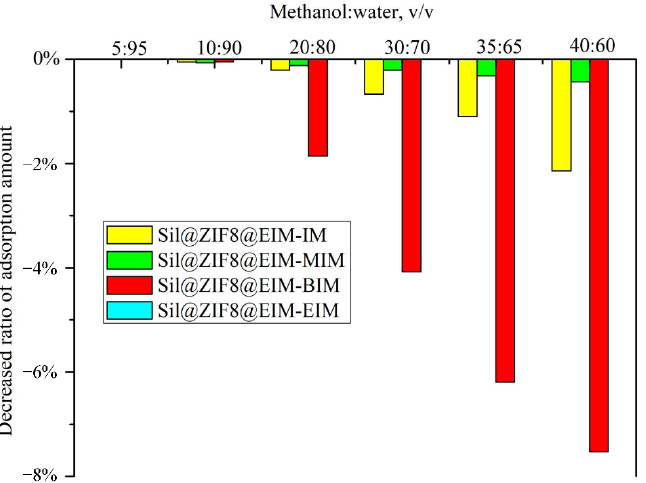
Figure 7. Effect of ratio of methanol in solution.